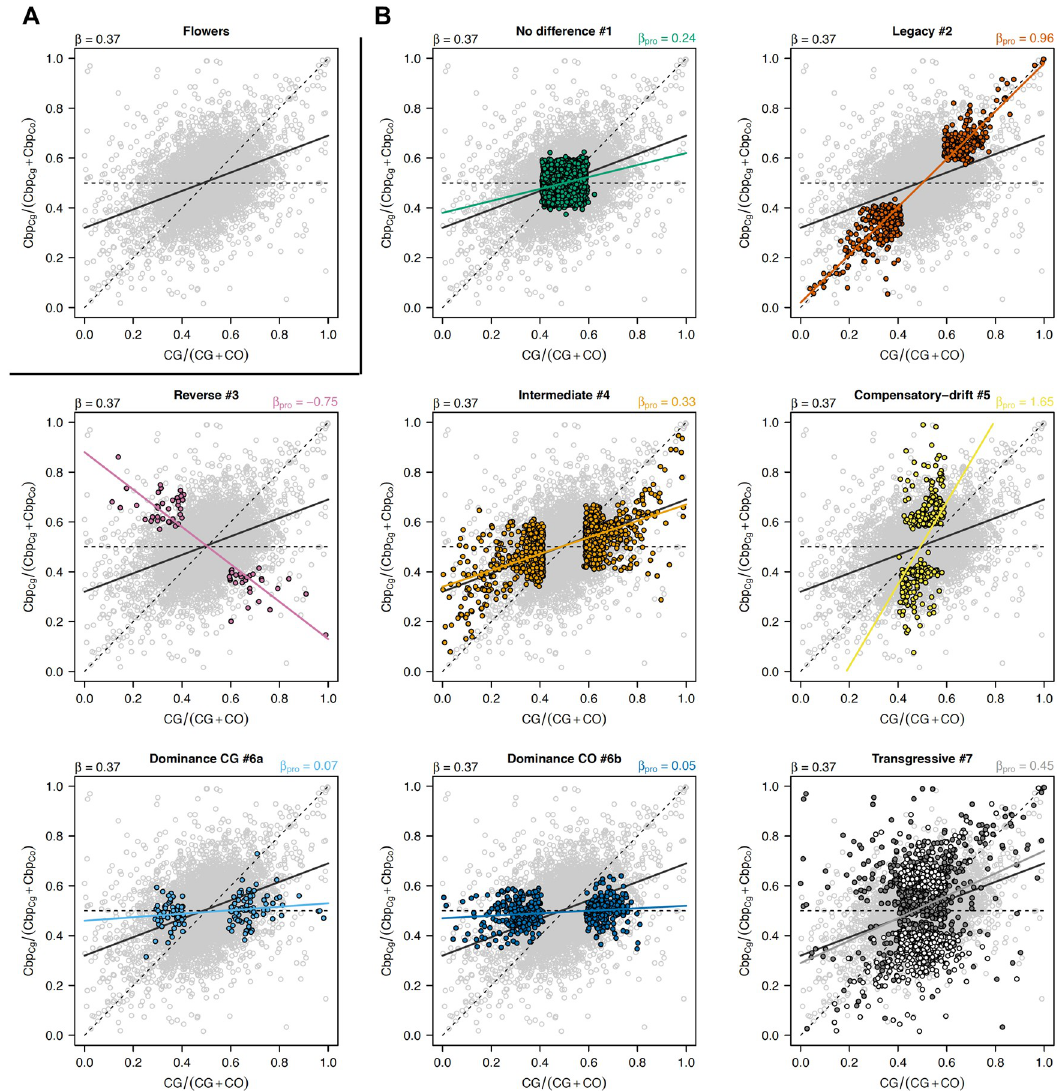
Fig 5. Relationships between the relative expression of the C. bursa-pastoris subgenomes and the relative expression of parental species. The figure shows expression in flower as an example. A . Top-left panel is for all transcripts (11,931). B . Transcripts belonging to a specific category. The diagonal dashed lines indicate 100% cis -regulation divergence while the horizontal dashed lines indicate 100% trans -regulation. The solid lines give the slopes of the linear regressions between both ratios either for all transcript (black) or for transcript belonging to a specific category. β is the slope of the corresponding regression. For Transgressive category (bottom right panel), dark gray corresponds to categories #7a and b, light grey is for category #7c (see Fig 6).